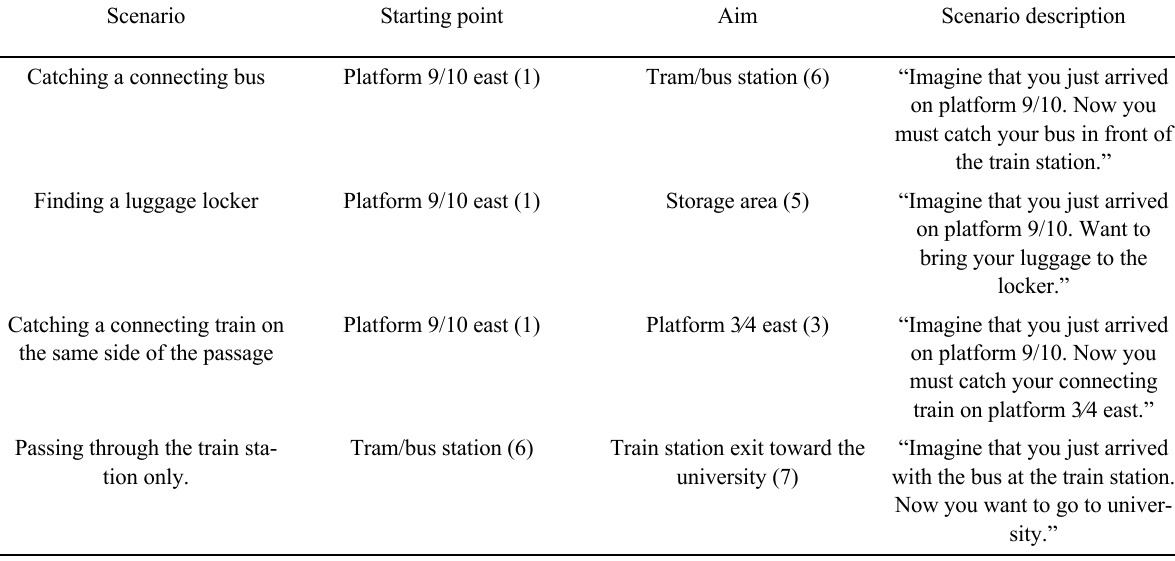
Table 1. A selection of the scenarios containing the tasks for the participants are described. Each task had a starting and ending point. The numbers are illustrated in the map in Figure 3. A description of all scenarios is presented in the appendix (Table 3).